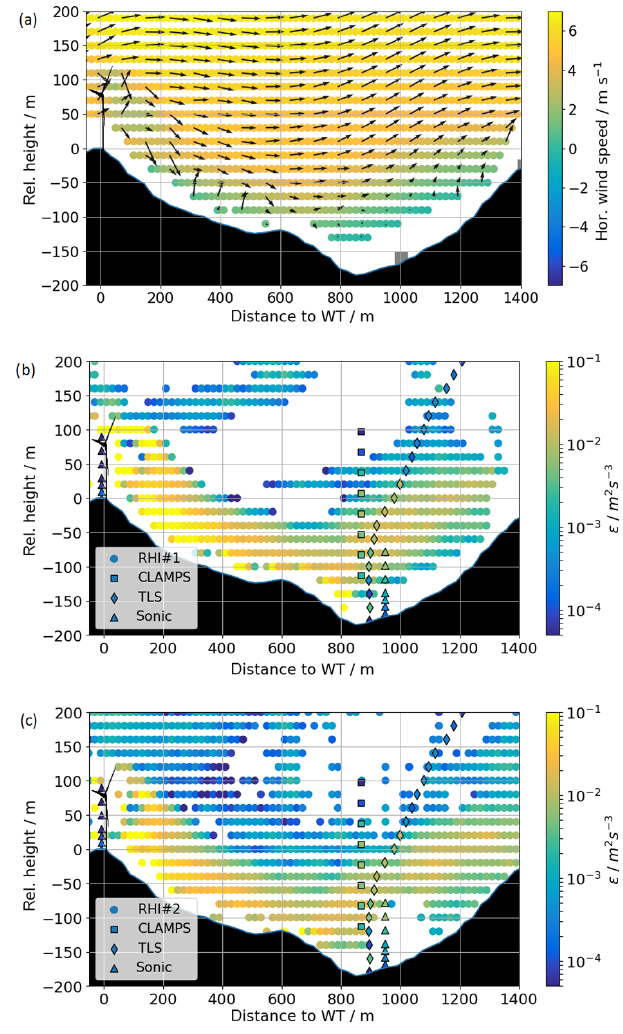
Figure 14. In panel (a) the coplanar wind field reconstruction from RHI#1 and RHI#2 from averaged RHI scans between 05:30 and 06:00UTC is shown. The arrows show the wind vectors projected onto the RHI plane as retrieved with the coplanar method (Wild- mann et al., 2018a). The color map is scaled with the horizontal wind component of the projected wind vector. Panels (b, c) show dissipation rates as estimated from CLAMPS, TLS, and towers 20/trSE_04 and 25/trSE_09 on scans by RHI#1 (b) and RHI#2 (c) for the same time